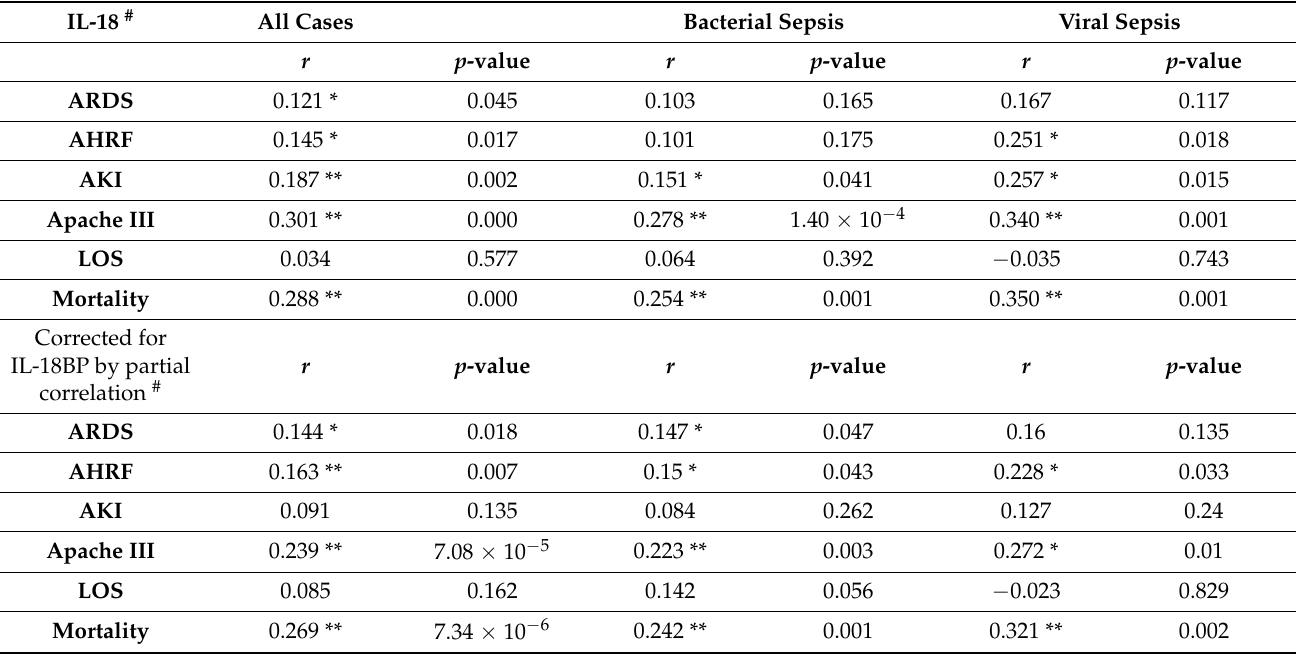
Table 3. Correlation of quantitative Ln (IL-18) levels with organ